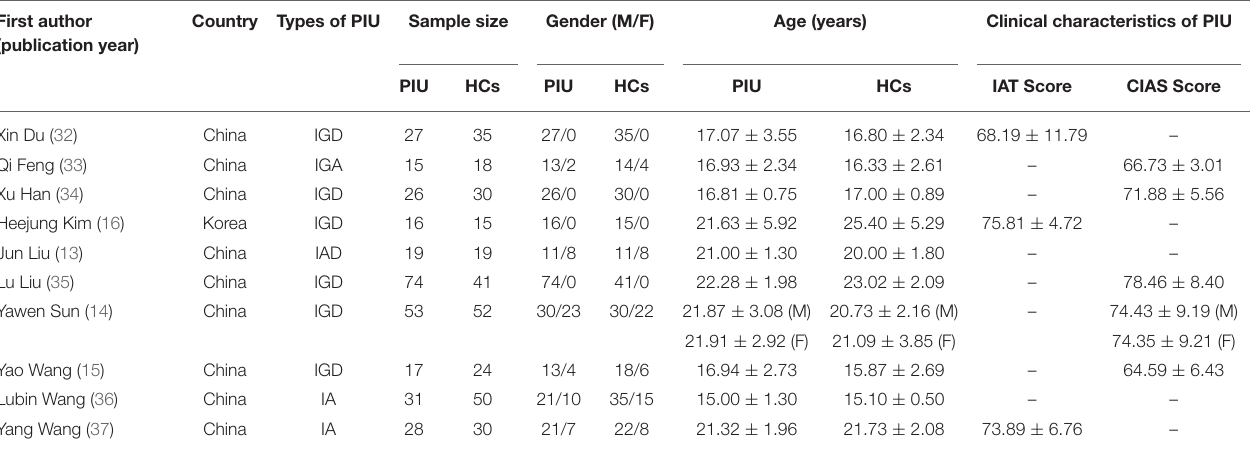
TABLE 1 | Demographics and clinical characteristics included in this